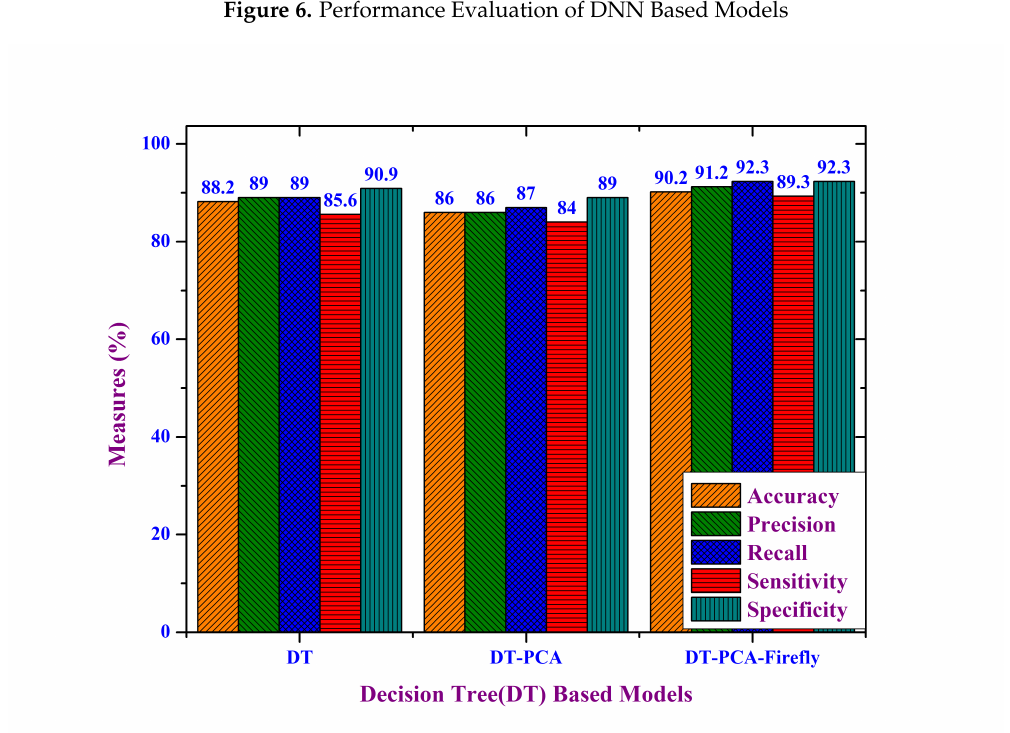
Figure 6. Performance Evaluation of DNN Based Models